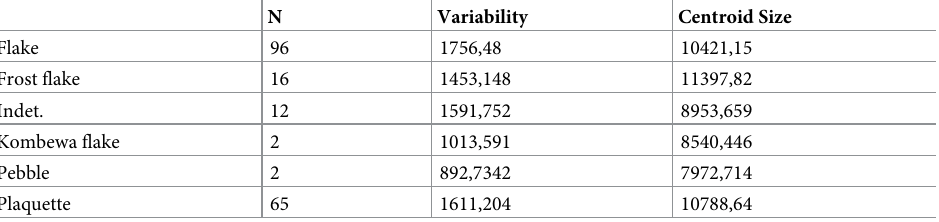
Table 10. Morphological variability and centroid size of tools according to the initial raw